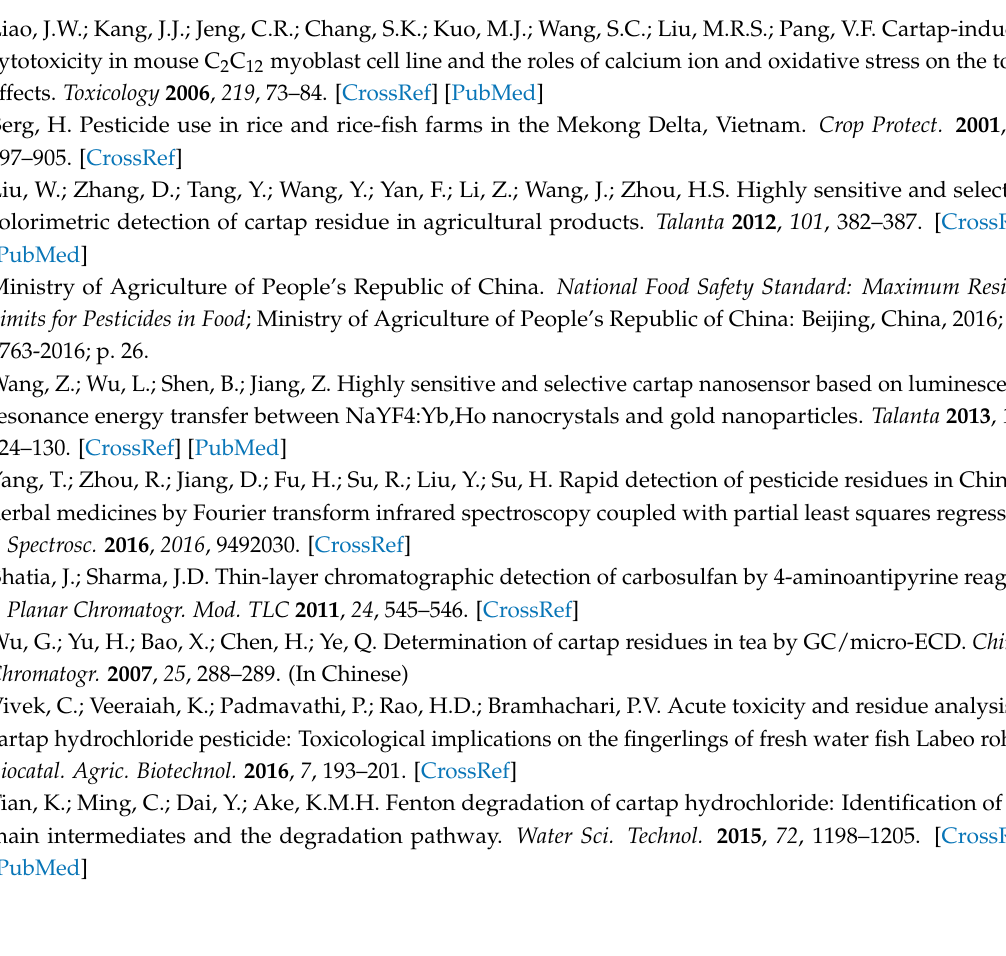
s1, Figure S1: The FT-IR spectra of (a) Fe 3 O 4 , (b) Fe 3 O 4 @CTAB/SiO 2 , (c) vinyl modified Fe 3 O 4 @mSiO 2 and (d)